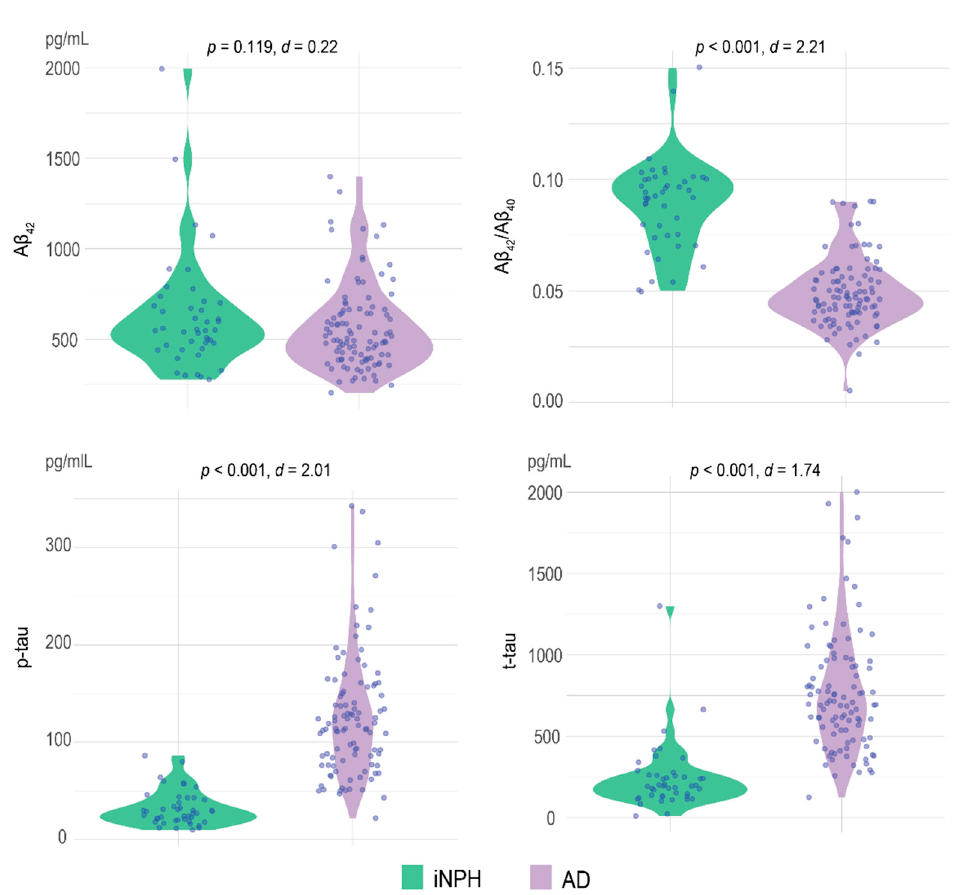
Figure 2. Comparison of the CSF biomarker concentrations and A β 42 /A β 40 ratio between iNPH and AD. Values quoted on the y -axis indicate the CSF concentration (expressed as pg/mL) for A β 42; p-tau, t-tau, and the value of the ratio for the A β 42 /A β 40 . p -values and Cohen’s d are reported. Statistical significance received a Bonferroni adjustment and was accepted at p <